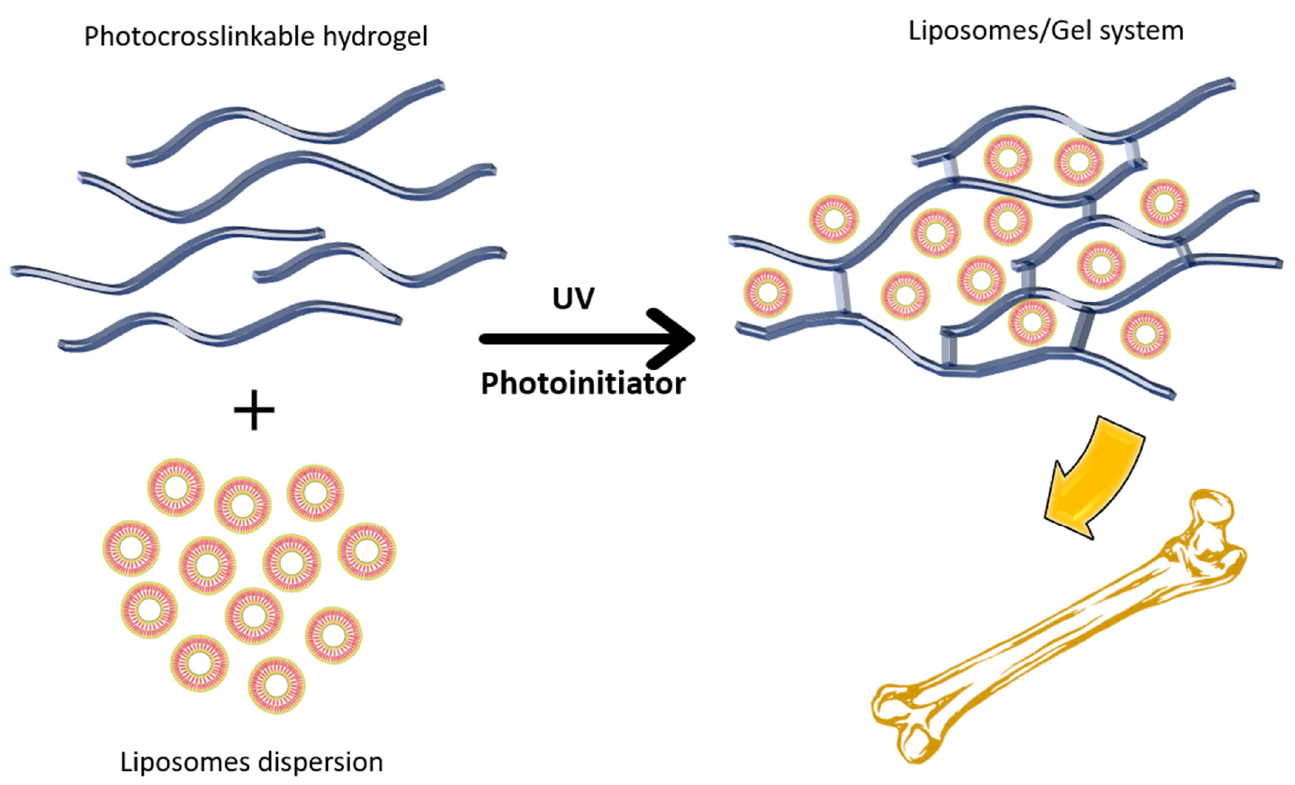
Figure 6. Liposome- hydrogel with enhanced residence time over bone.